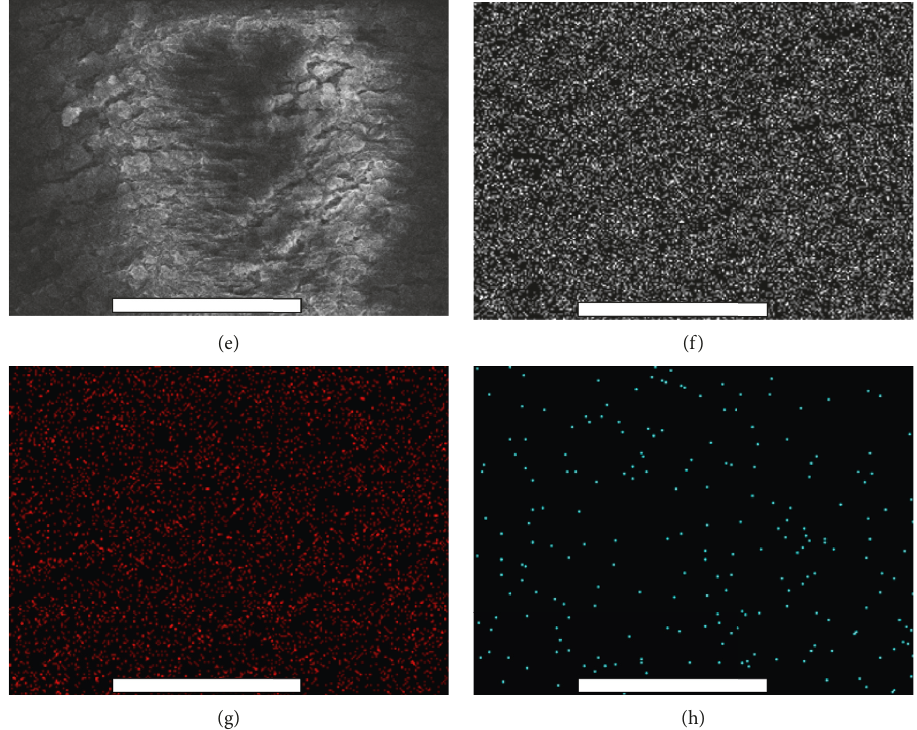
Figure 9: SEM images of (a) the pristine PBS in comparison with the (b) 3AgCB-PBS, (c) 5AgCB-PBS, (d) 10AgCB-PBS, and (e) 15AgCB- PBS composites. The corresponding EDS elemental mappings of (f) C element, (g) O element, and (h) Ag element of the 15AgCB-PBS composite illustrate the well distribution of the AgCB additive within the PBS matrix. Note that the scale bar depicted in Figures 9(a) to 9(d) is 10 μ m, while the one depicted in Figures 9(e) to 9(h) is 20 μ m.